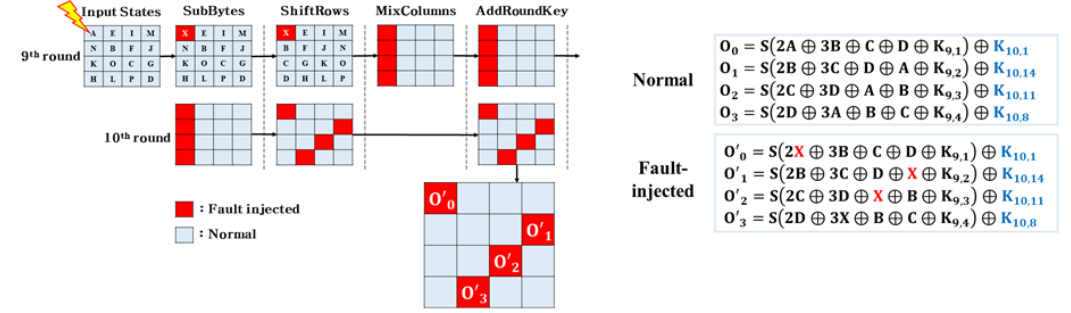
Figure 2. Propagation process of fault induced in the input of 9th round of advanced encryption standard